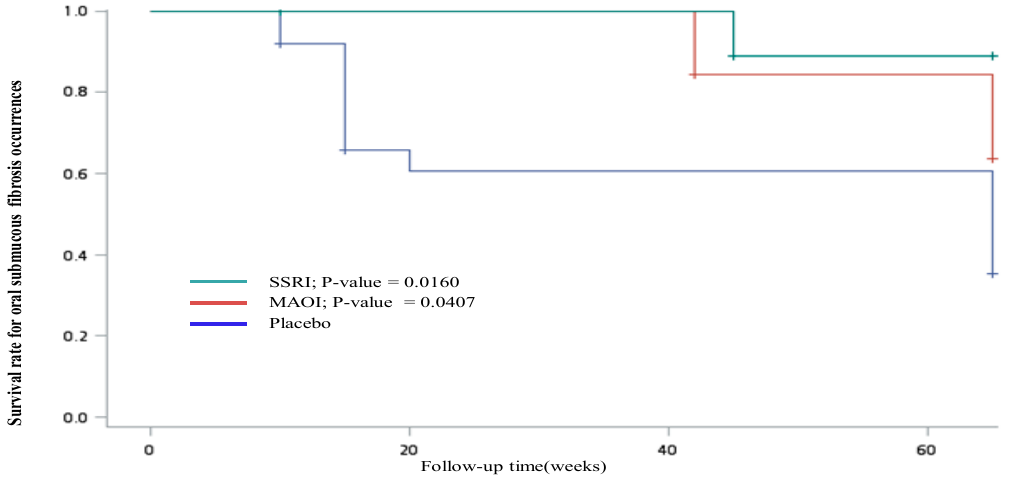
Figure 3. Effects of areca-nut use on oral submucous fibrosis risk after antidepressant treatment analyzed with Kaplan–Meier method in animal